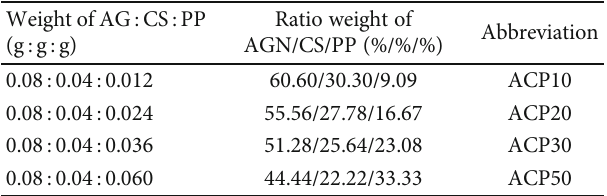
Table 1: Composition and abbreviation of AGN/CS/PP